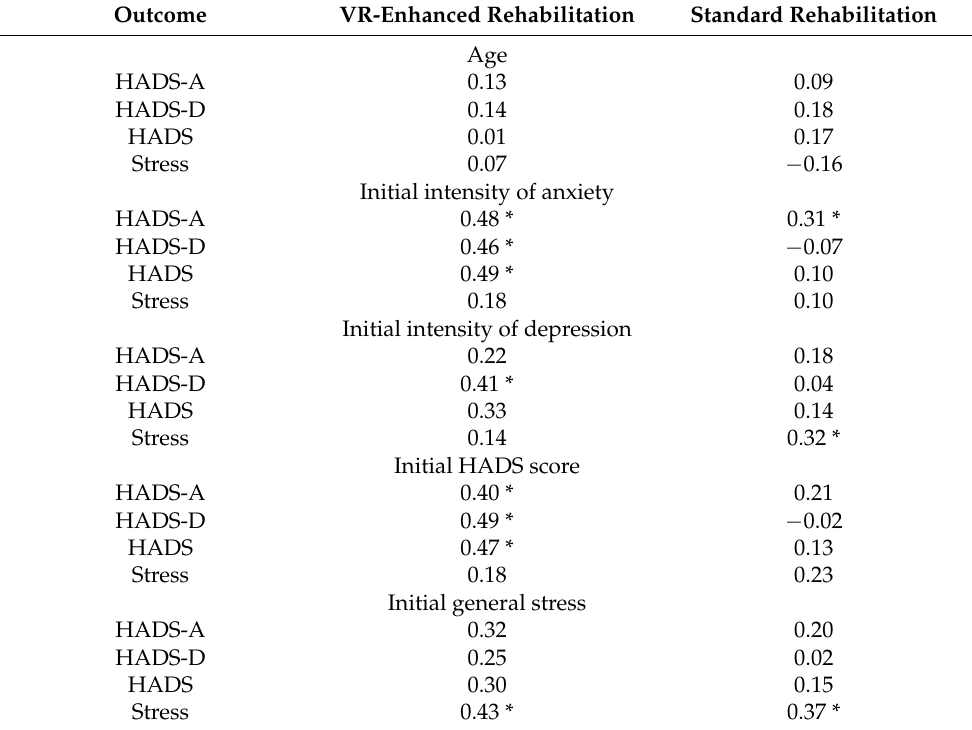
Table 4. Correlation of improvement of mental state in VR-enhanced rehabilitation and standard